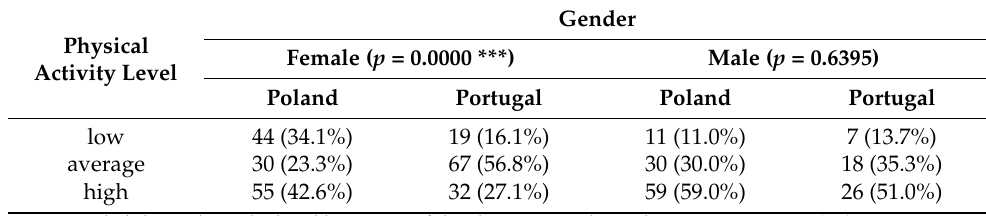
Table 6. Summary of IPAQ measure classifications.